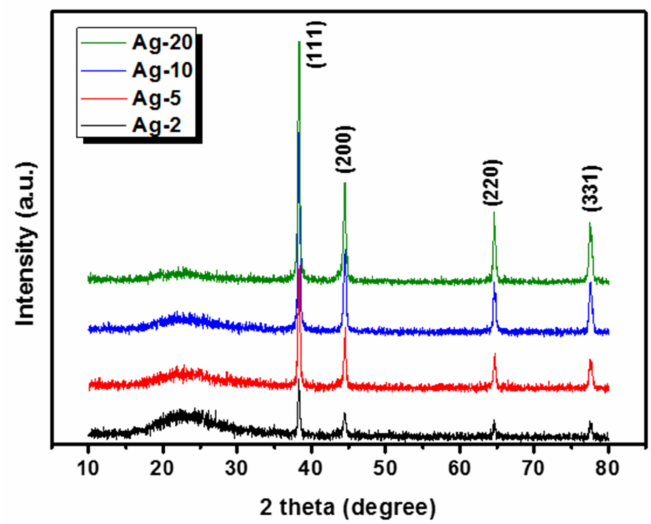
Figure 2. XRD patterns of the prepared silver nanoparticles supported on bio-based